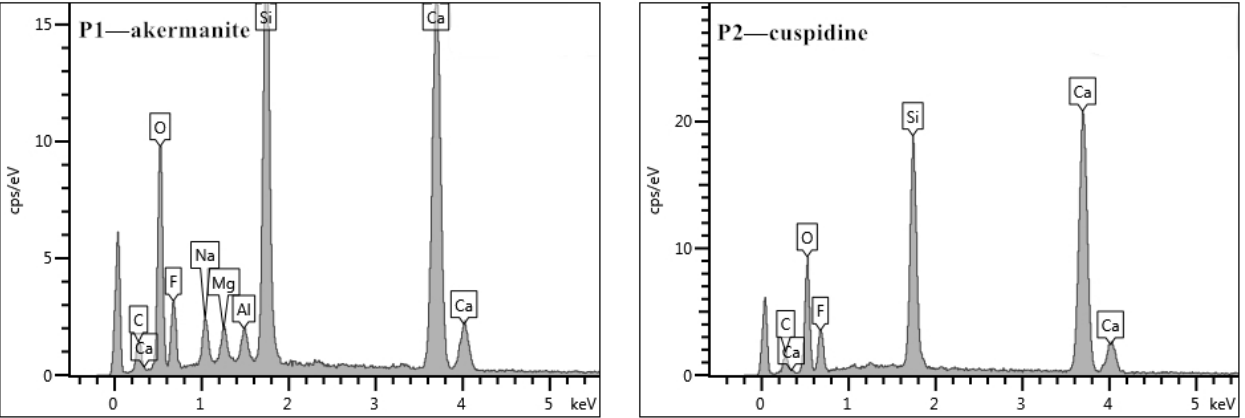
Figure 6. EDS spectra of different mineral crystals in flux films by EPMA.